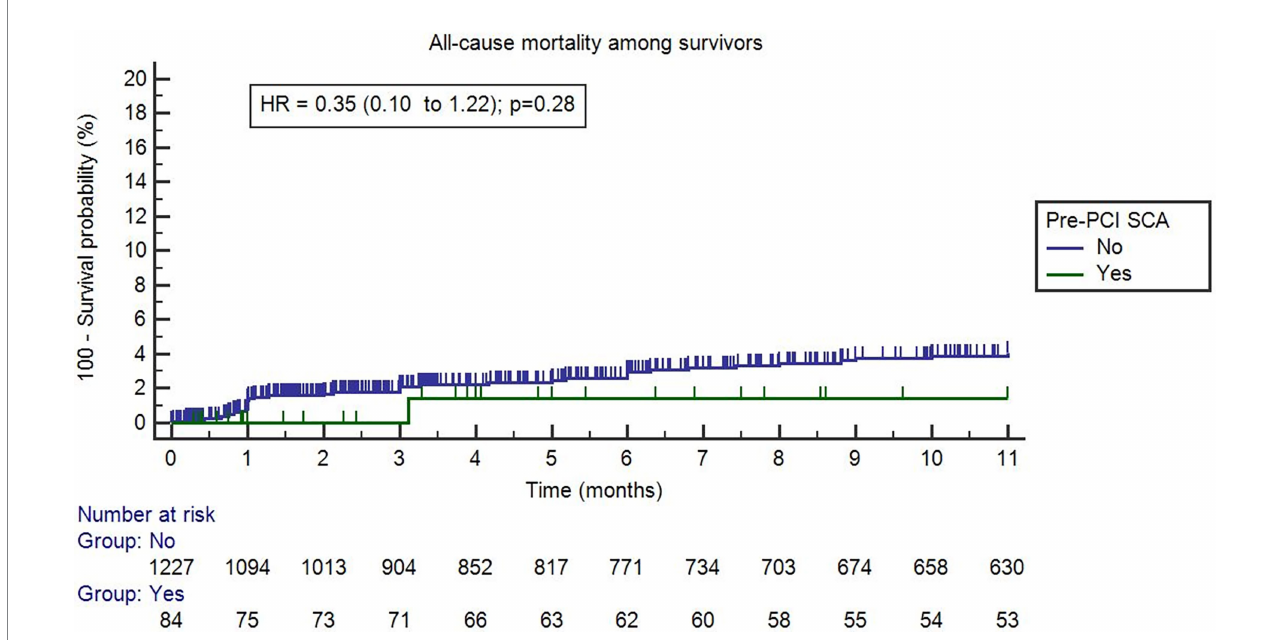
FIGURE 3 Time-to-event curves for all-cause mortality among survivors. Time “0” refers to hospital discharge. Event rates were calculated with the use of Kaplan– Meier